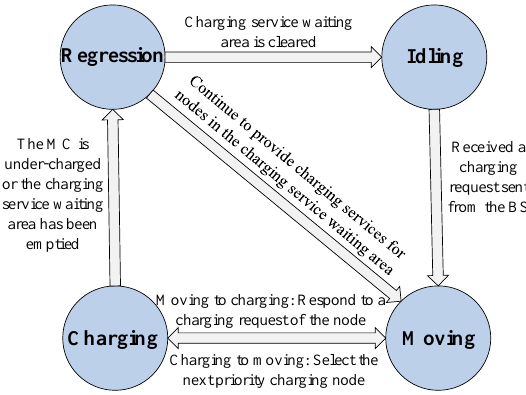
Figure 3. State transmission of the mobile charger (MC).